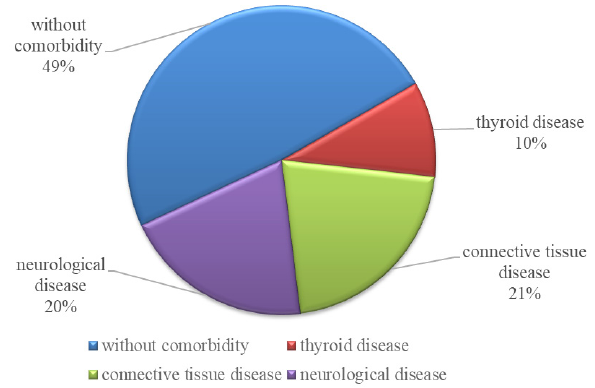
Fig. 5. Diagnosis according to capillaroscopic examination.